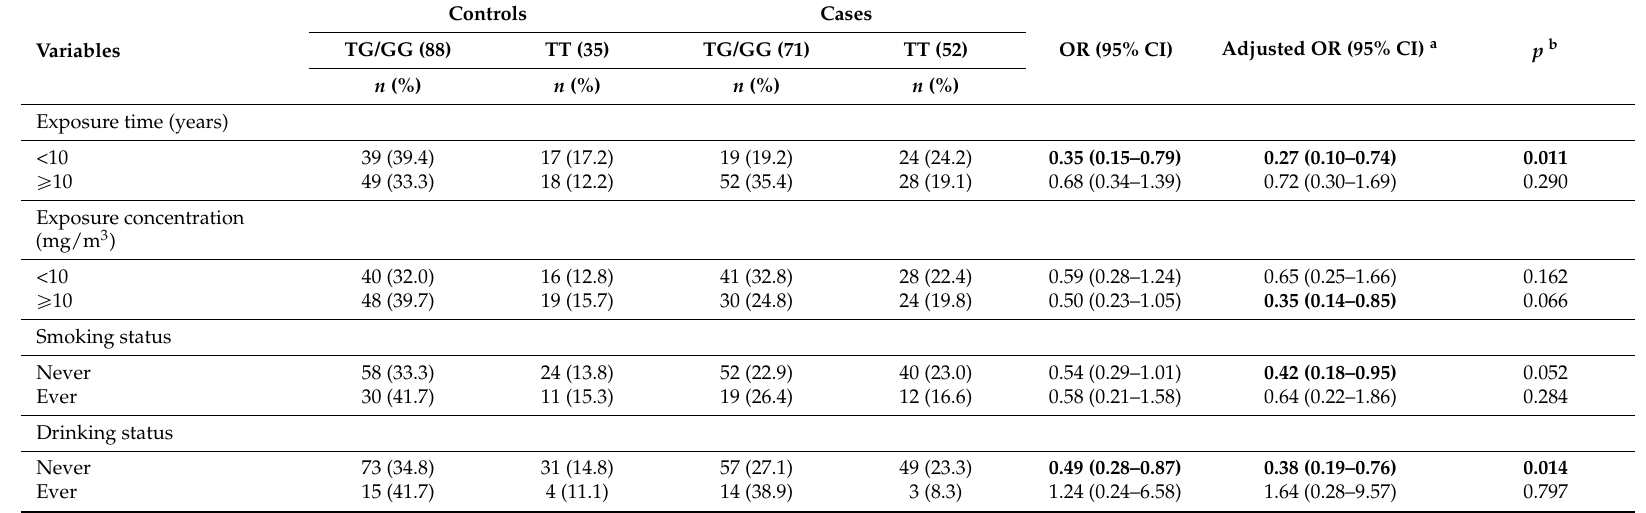
Table 3. Stratified analysis of the APE1 rs1760944 genotypes (TG/GG vs. TT) associated with the risk of DMF-induced abnormal liver